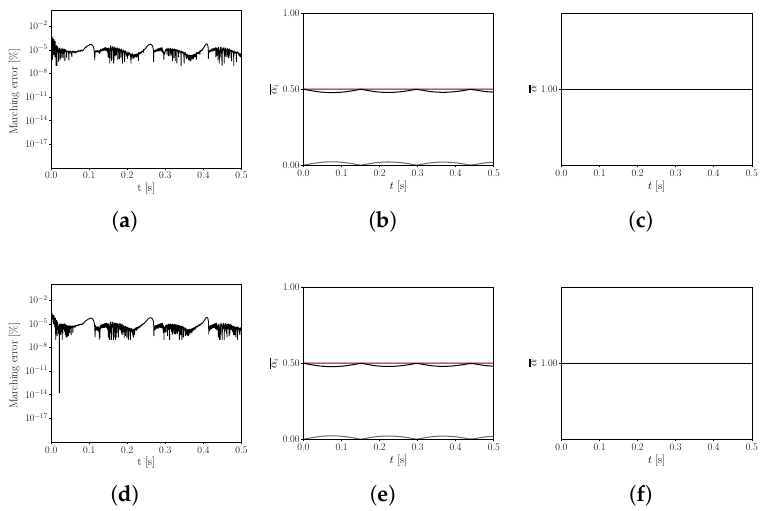
Figure 18. Evolution time of ( a , d ) marching error; ( b , e ) volume-weighted void fractions; ( c , f ) sum of the volume-weighted void fractions. Grid A: ( a – c ), Grid B: ( d – f ). Legend: α l ( ), α v ( ),